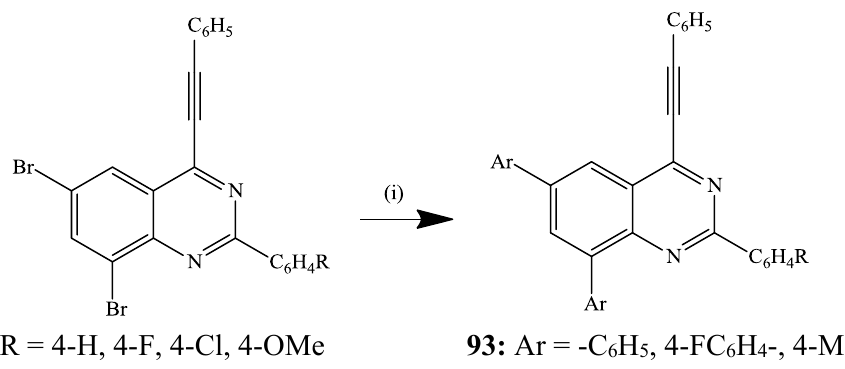
2-aryl-6,8-dibromo-4-methoxyquinolines [50] and tribromoquinoline